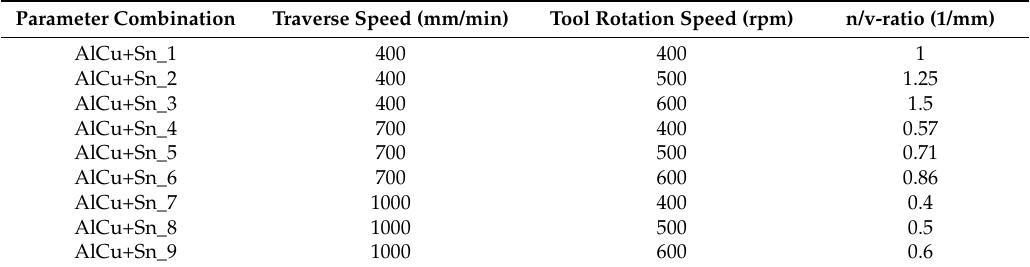
Table 3. Full factorial experimental plan for welding experiments for aluminum with tin coated